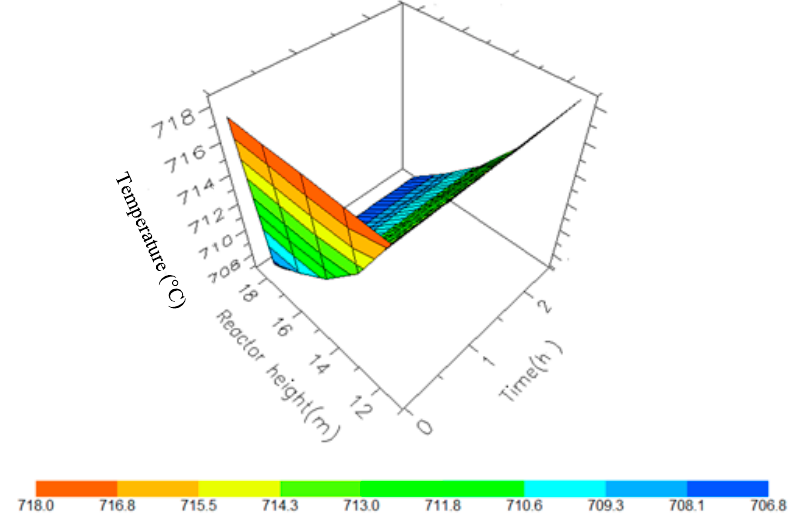
Figure 12. A 3D representation of Reactor 3 Temperature variation with reactor height and time.